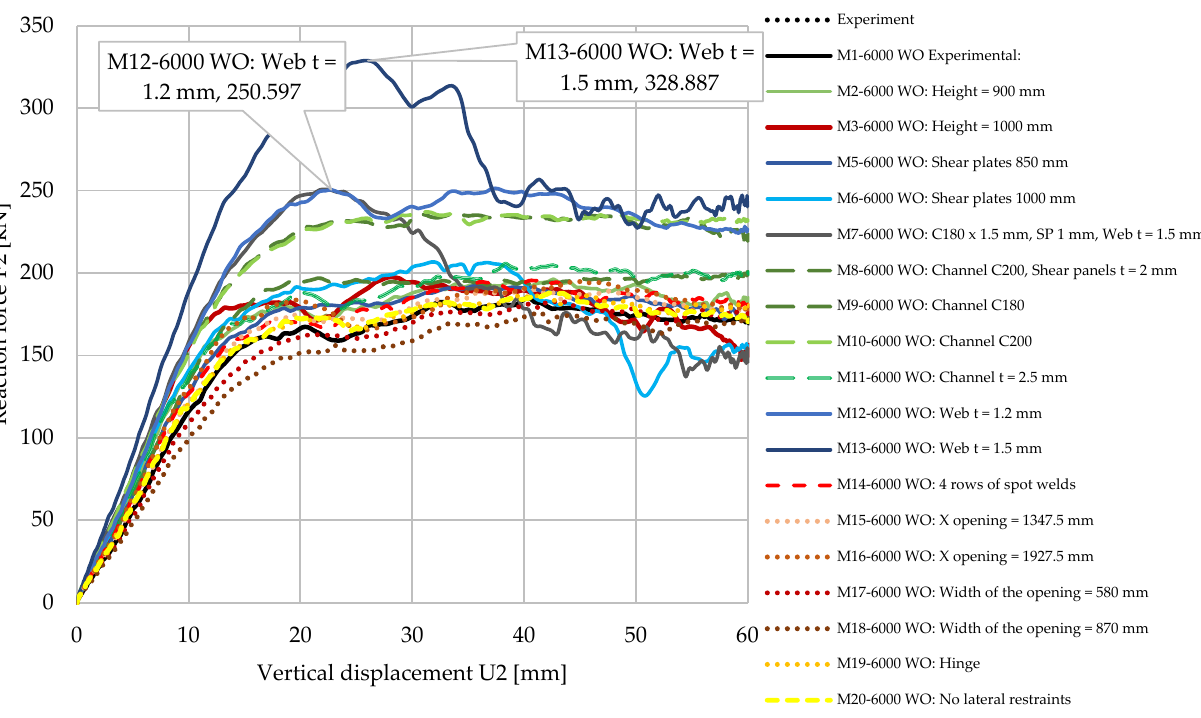
Figure 17. Parametric study for the beam with a web opening and a length of 6000 mm.